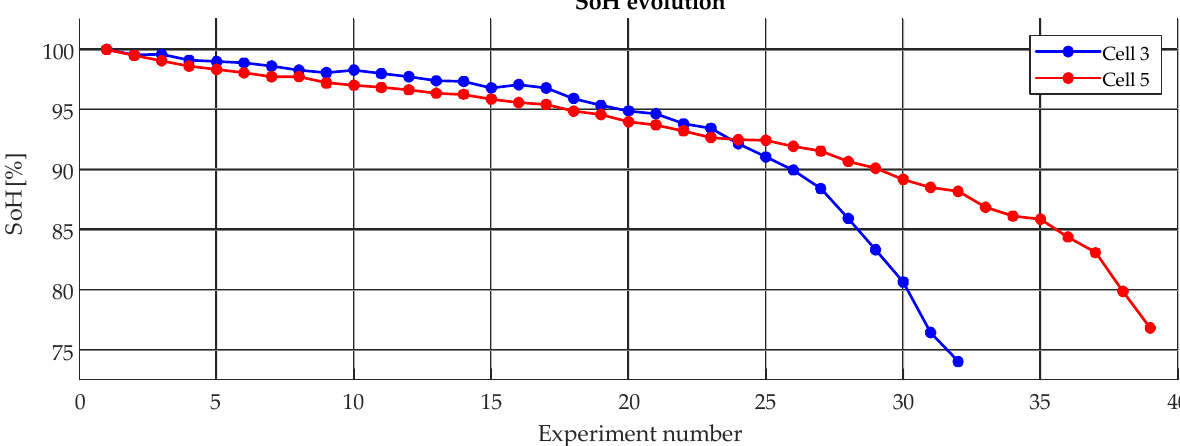
Figure 1. Comparison of SoH in battery cycling under different operating conditions. Represented values have been obtained from the database used in the study.